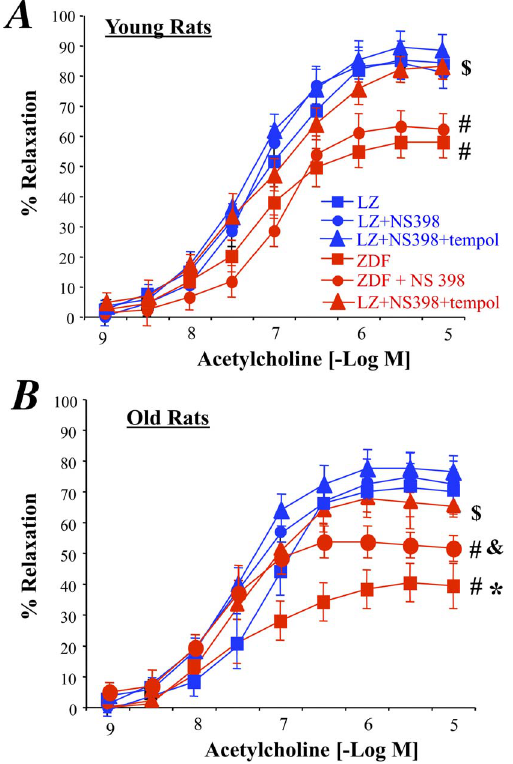
Figure 5. Effect of an acute treatment of mesenteric resistance arteries with the COX-2 inhibitor NS398 or NS398 and the antioxidant tempol on acetylcholine-induced relaxation in young (A) and old (B) LZ and ZDF rats. Mean 6 SEM is presented (n=10 per group). # P , 0.01, ZDF versus LZ. *P , 0.01, old versus young rats. & P , 0.05, effect of NS398 alone on